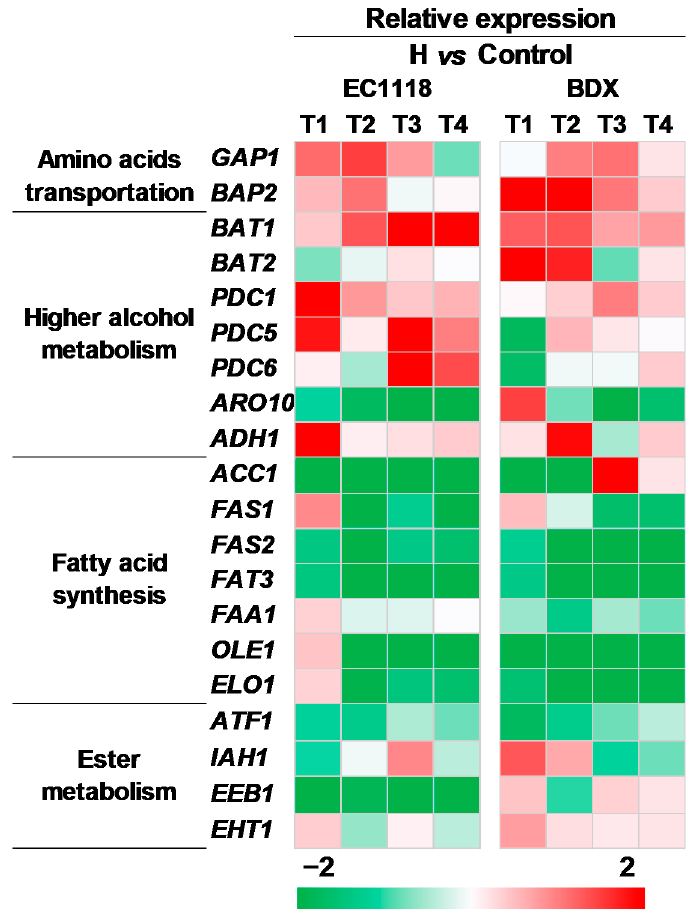
Figure 4. The comparison of aroma gene expressions in EC1118 and BDX strains fermented in high-UFAs addition vs. the control juice. T1, T2, T3, and T4 represented the mid-exponential phase, the early-stationary phase, the mid-stationary phase, and the end of fermentation, respec- tively.